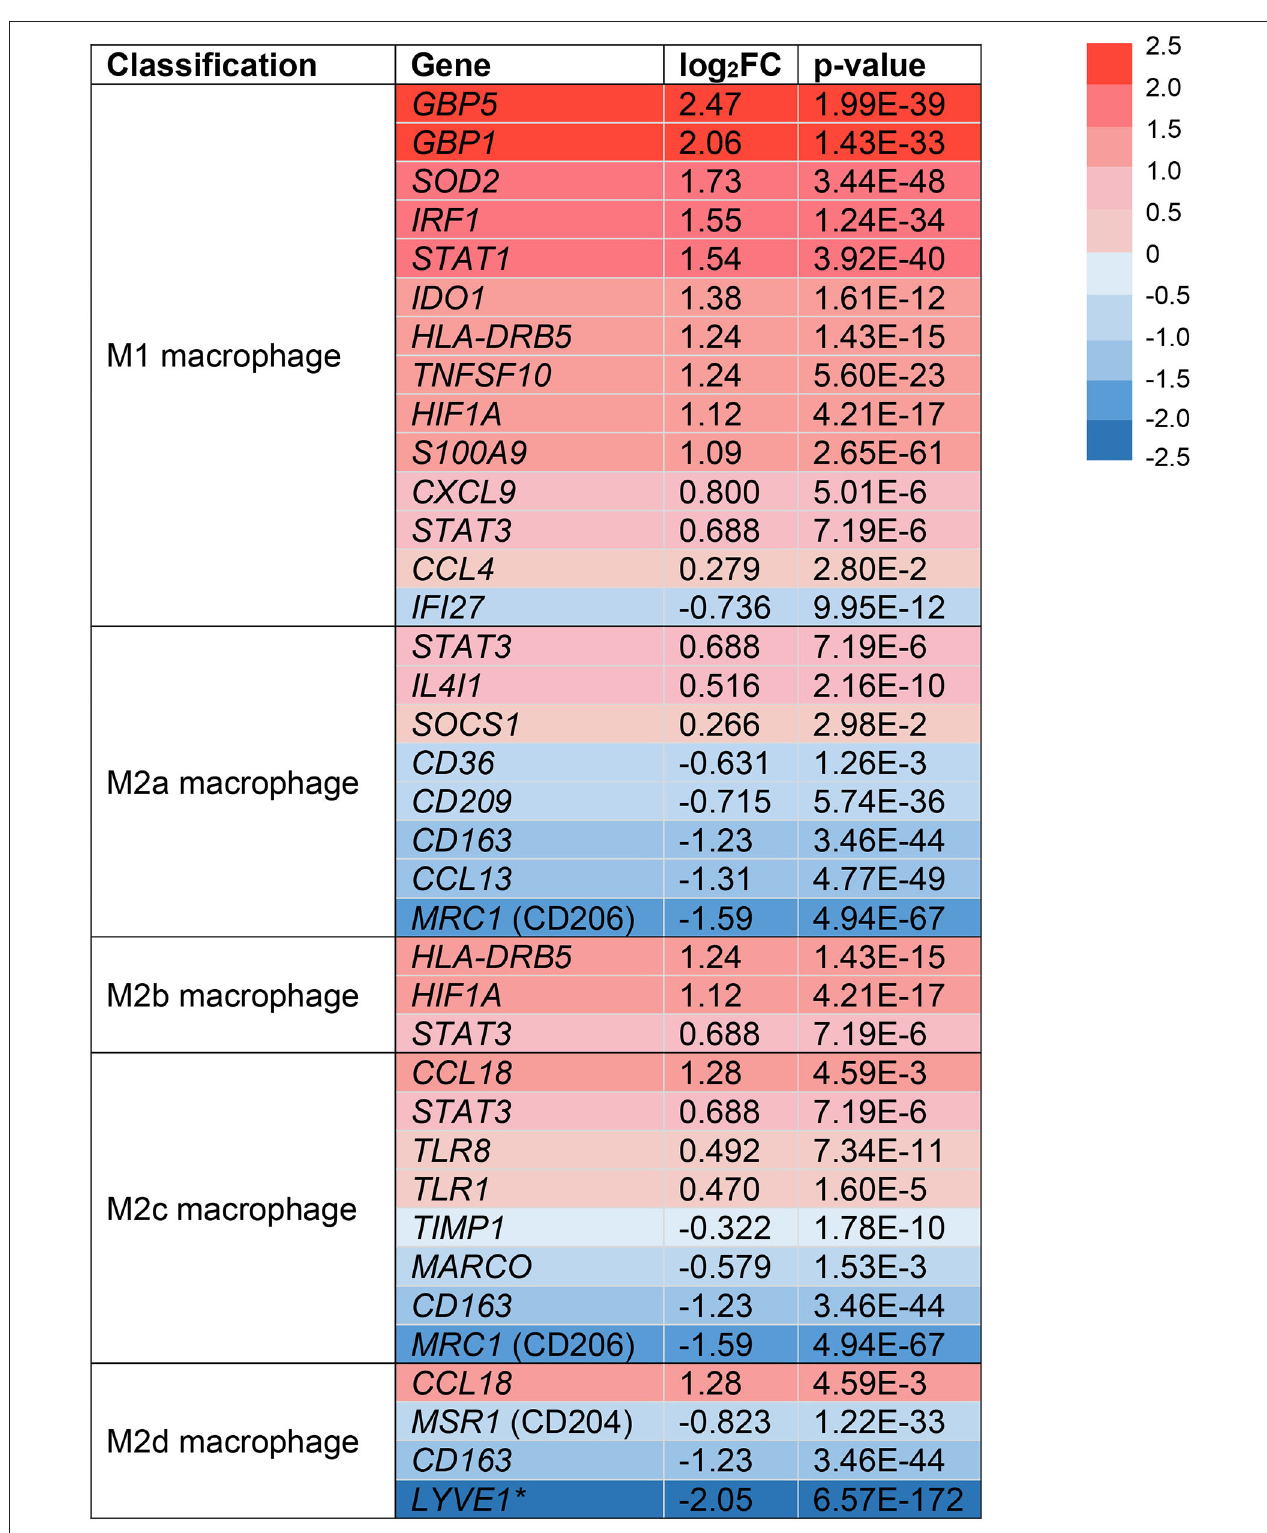
FIGURE 3 | Monocyte/macrophage populations are transcriptionally polarized toward an M1 macrophage phenotype in HS skin. log 2 FC of gene expression was calculated by comparing HS samples to HC skin within the monocyte/macrophage clusters. Values that depict an increased log 2 FC gene expression in HS relative to HC are colored in red and those that depict a decreased expression are colored in blue. *Expressed in tumor-associated macrophages. FC, fold change; HC, healthy control.